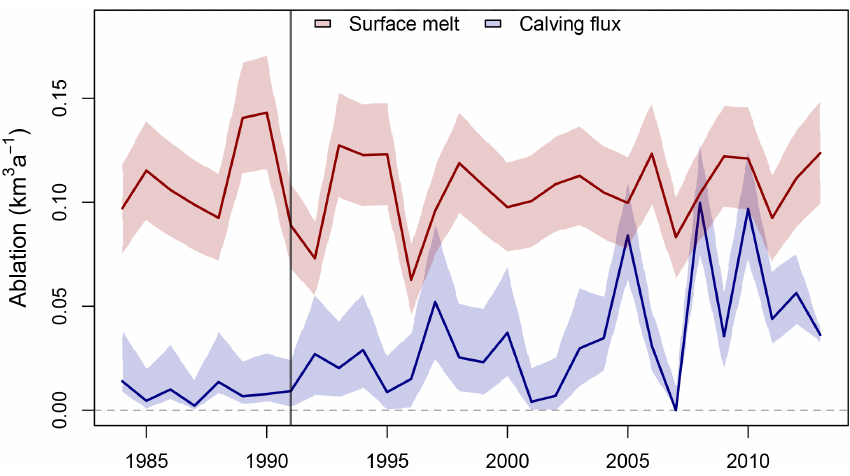
Figure 11. Historical ablation from calving and surface melt (below the ELA), 1984–2013. The dark vertical line in 1991 indicates the period in which the terminus reached flotation and calving rates increased. Shaded areas correspond to calculated